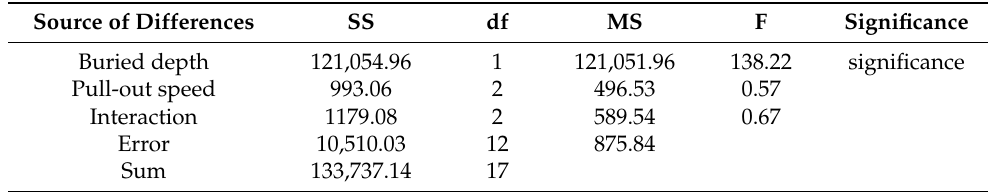
Table 8. ANOVA of the average maximum pull-out force under different burial depths and pull- out speeds.